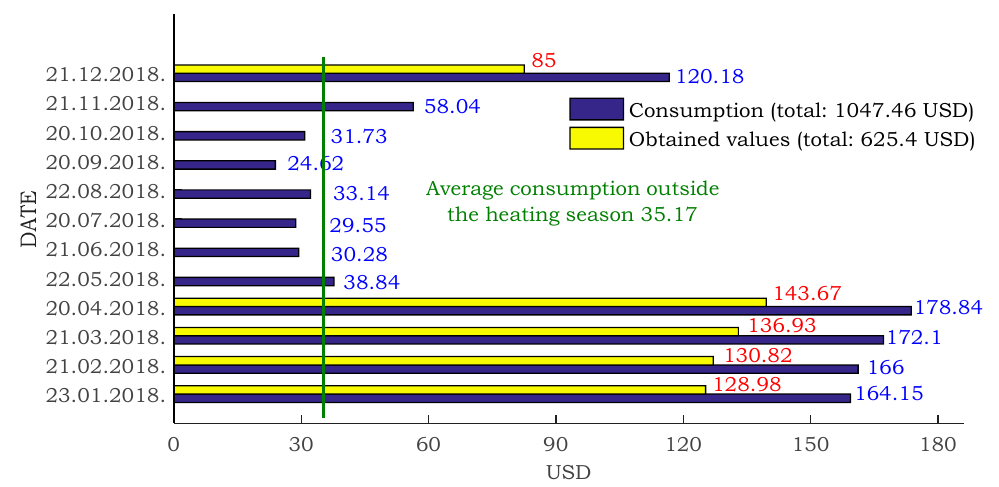
Figure 11. Consumer’s electricity bill.